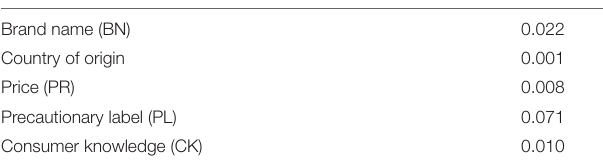
TABLE 6 | Effect size.